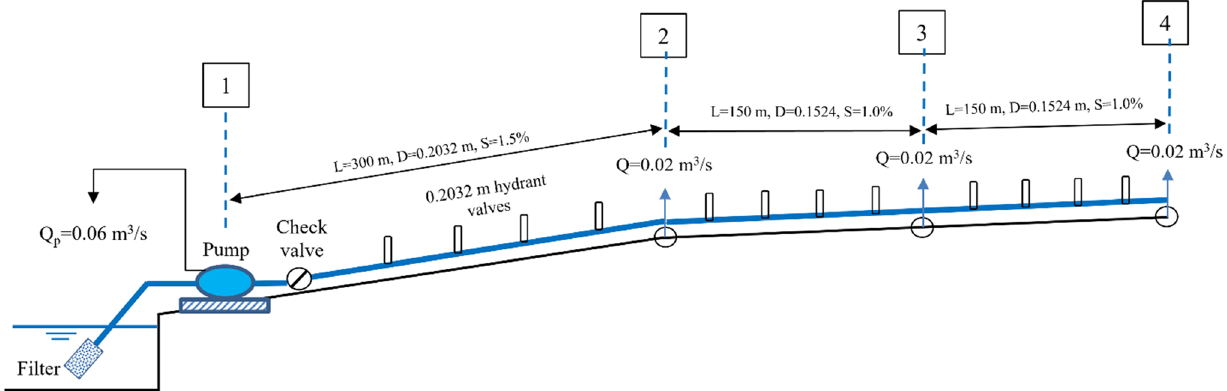
Fig. 3 Sprinkler irrigation system consists of three lateral pipes branching from the main